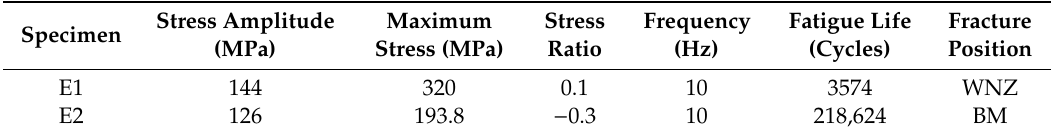
Table 5. Fatigue test data of FSW joints based on strain